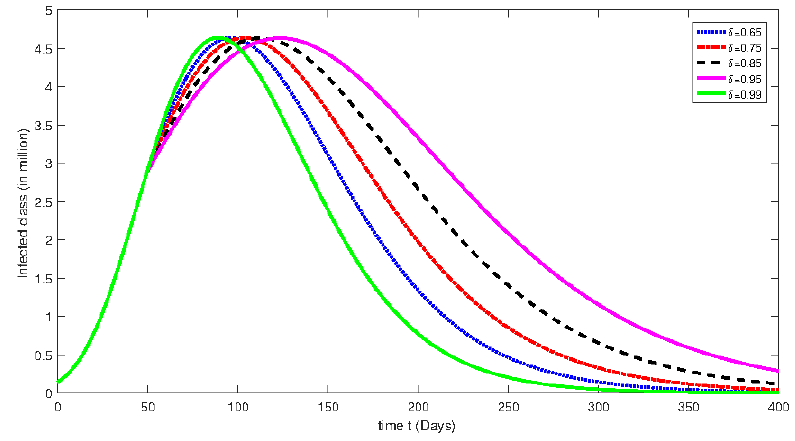
Figure 2. Numerical solution for infected class for the given days and using different fractional orders with isolation rate of 30%.